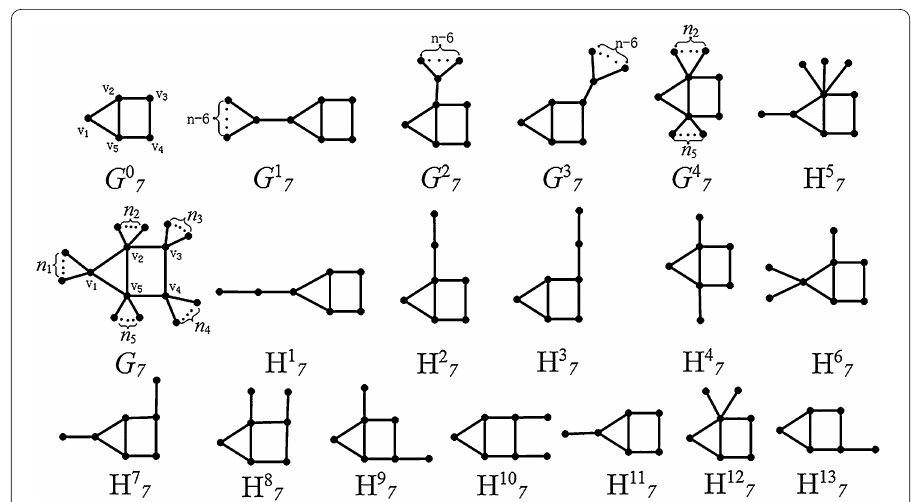
Figure 9 Some bicyclic graphs with θ (2,3,4) as their